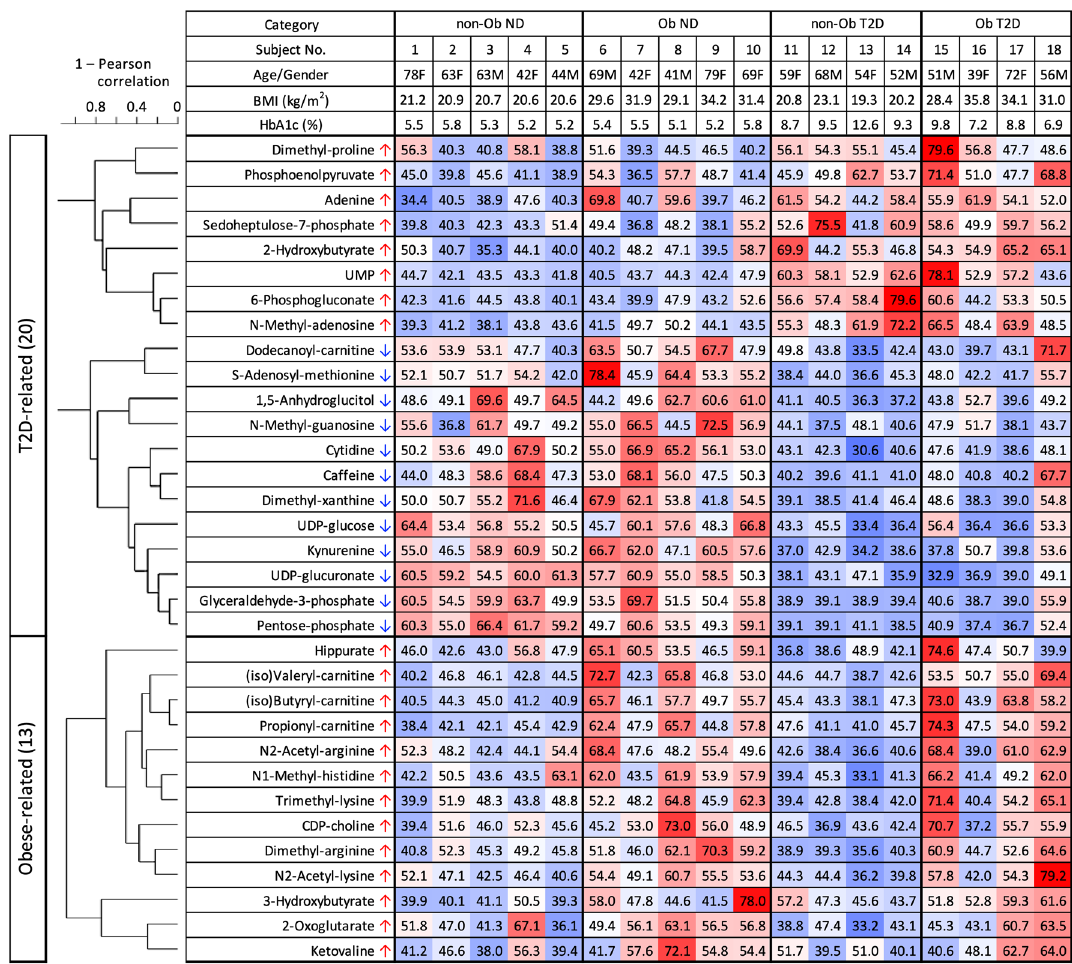
Figure 4. Hierarchical clustering heatmap of 20 T2D and 13 obesity-related compounds. A heat map was constructed for 18 subjects using a color matrix representing relative abundance data of 33 metabolites implicated in diabetes or obesity. Numerical values indicate the T score, a kind of standardized score. The average and standard deviation are 50 and 10, respectively. Blue cells indicate metabolite titers that are below average (50), whereas red cells indicate levels that are higher than average. Color intensity of cells reflects the T